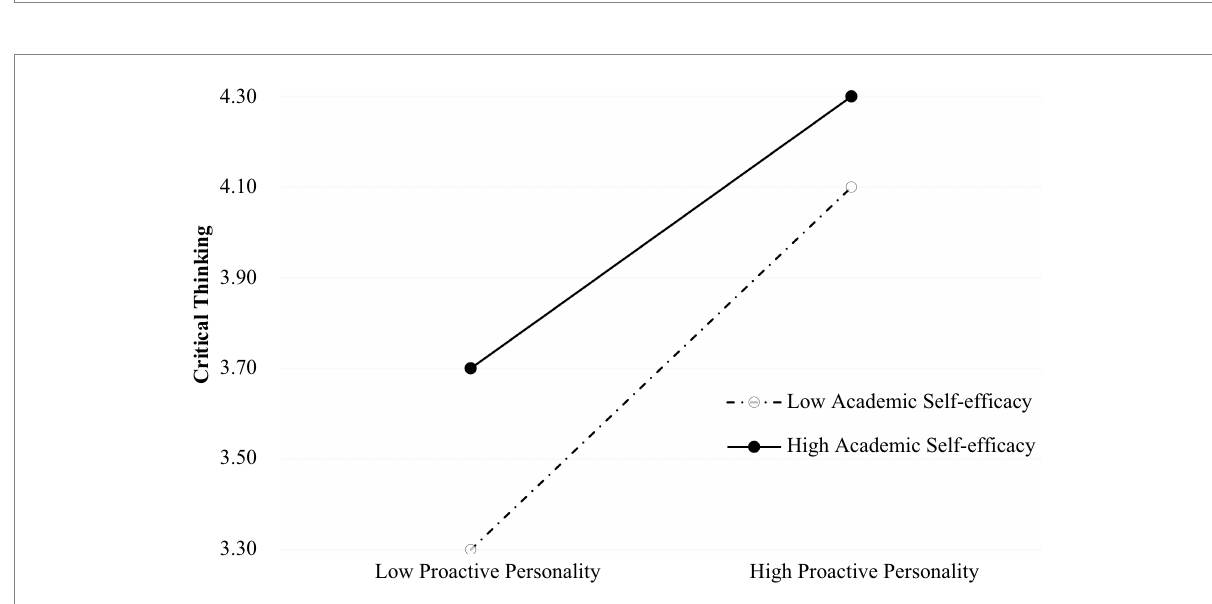
FIGURE 2 Simple slope plot of the interaction between proactive personality and academic self-efficacy on critical